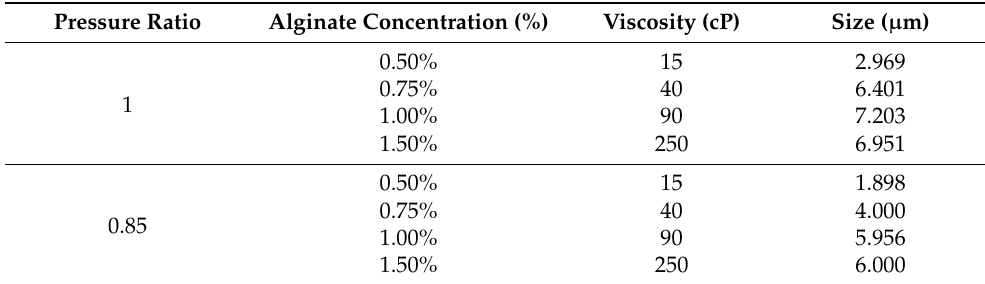
Table 3. Effects of the viscosity on the Alg-Ppz MPs